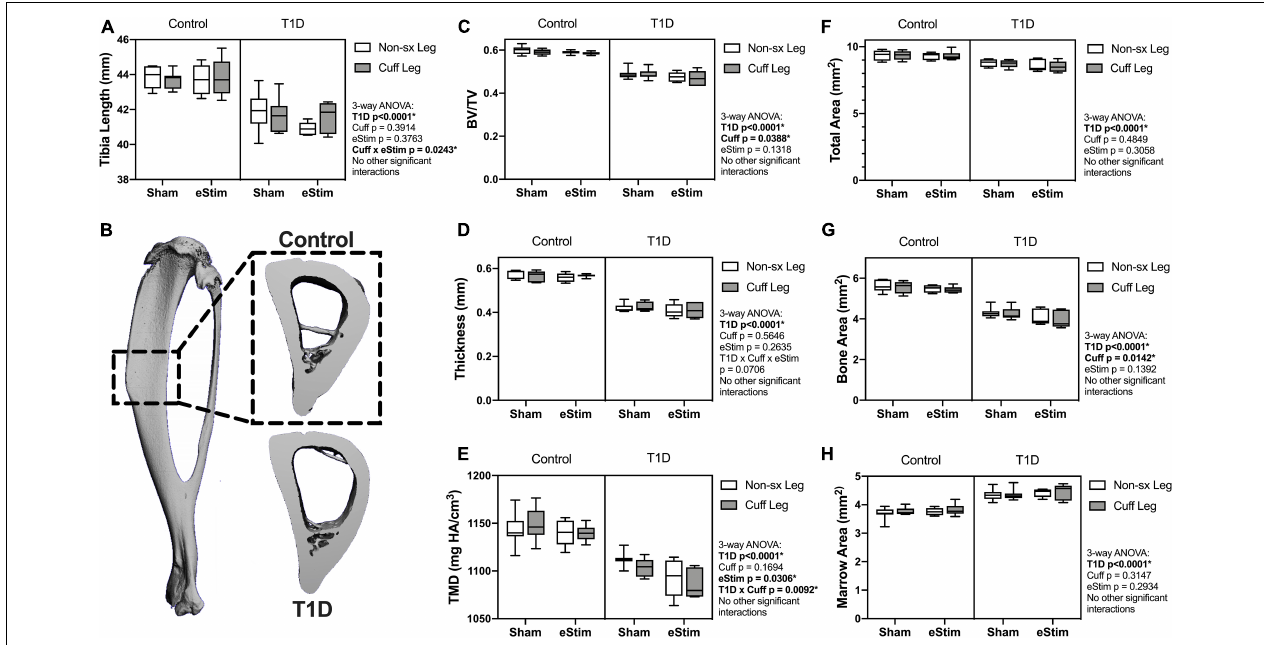
FIGURE 5 | Tibia length and cortical bone. (A) End point tibial length as assessed after dissection using digital calipers. Cortical bone was evaluated at 24-week of age by µ CT in a 3 mm region centered midway between the proximal end of the tibia and the tibia-fibula junction (B) . (C) Cortical bone volume fraction (BV/TV).